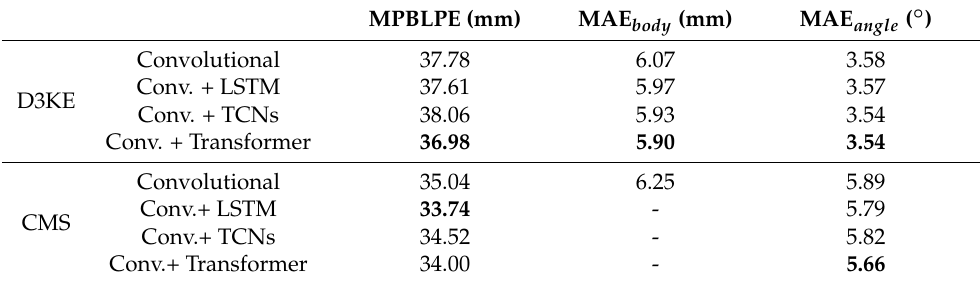
Table 1. Comparison of bony landmarks position (MPBLPE), body scales (MAEbody) and joint angles (MAEangle) between the estimation of and the ground truth across all participants, movements, joints and camera views. For the custom multi-step approach (CMS) as well as our proposed method, we compare convolutional networks with different temporal networks. All versions of the proposed method show superior performance for the prediction of body scales and joint angle estimation. All CMSs show superior performance in estimating marker positions. Each method group shows better performance for the task it was optimized for, highlighting the importance of direct optimization. Bold numbers indicate the best performance.